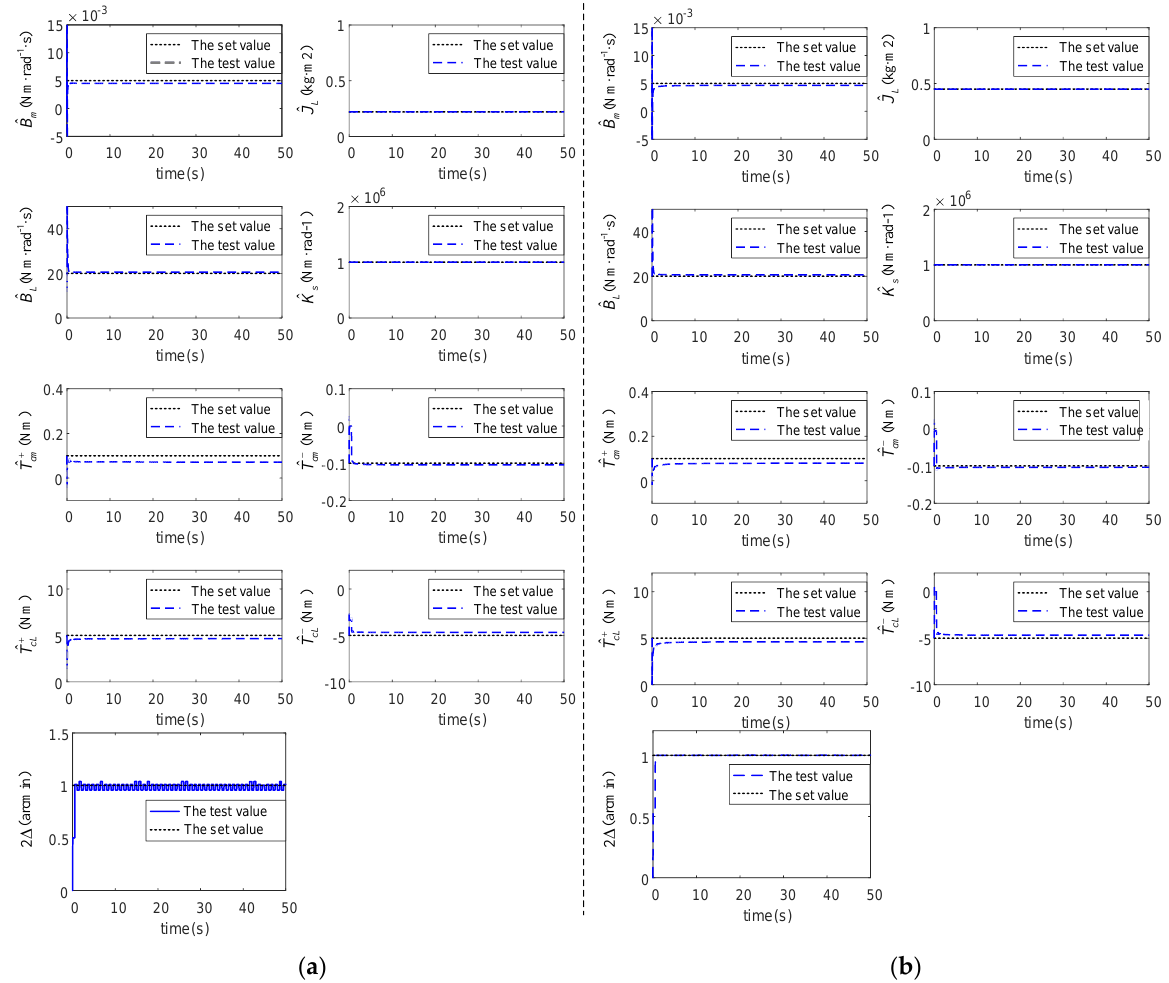
Figure 5. Convergence process of the multi-parameter online identification in the simulation. ( a ) Without load; ( b ) With load. Table 1. The converged values of the identification results in the simulation. Without Load With Load The Set The Estimated Error The Set The Estimated Parameters Value Value (%) Value Value